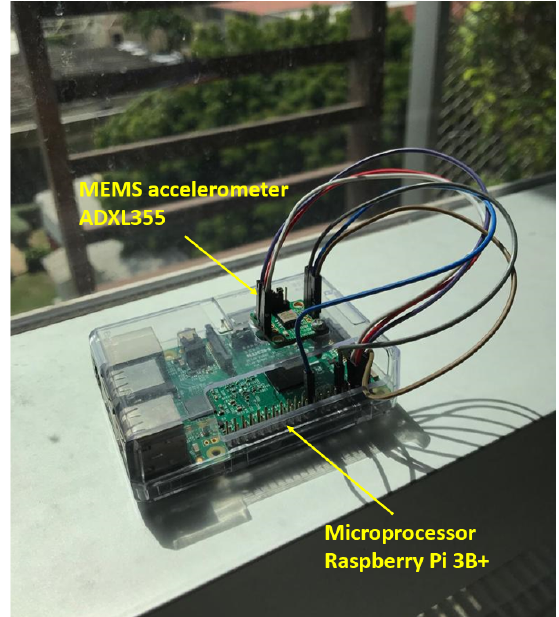
Figure 2. Measuring node of the low-cost SHM system.